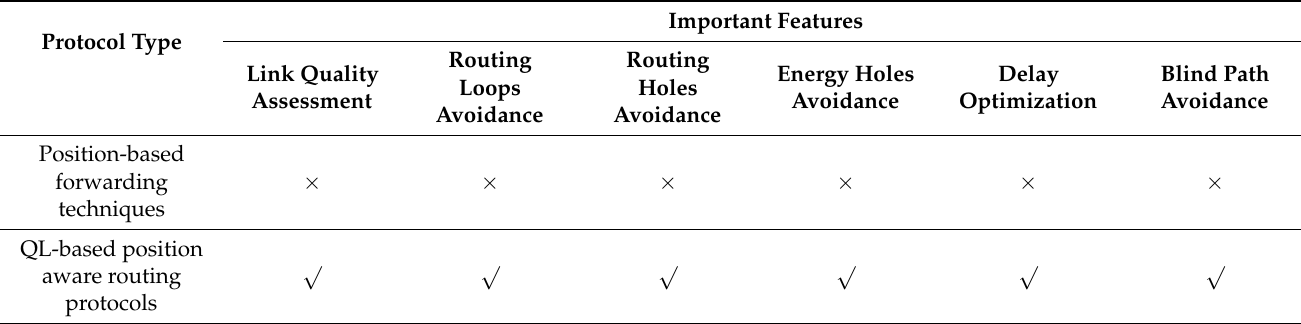
Table 4. Important features of position-based forwarding techniques and QL-based position-aware routing